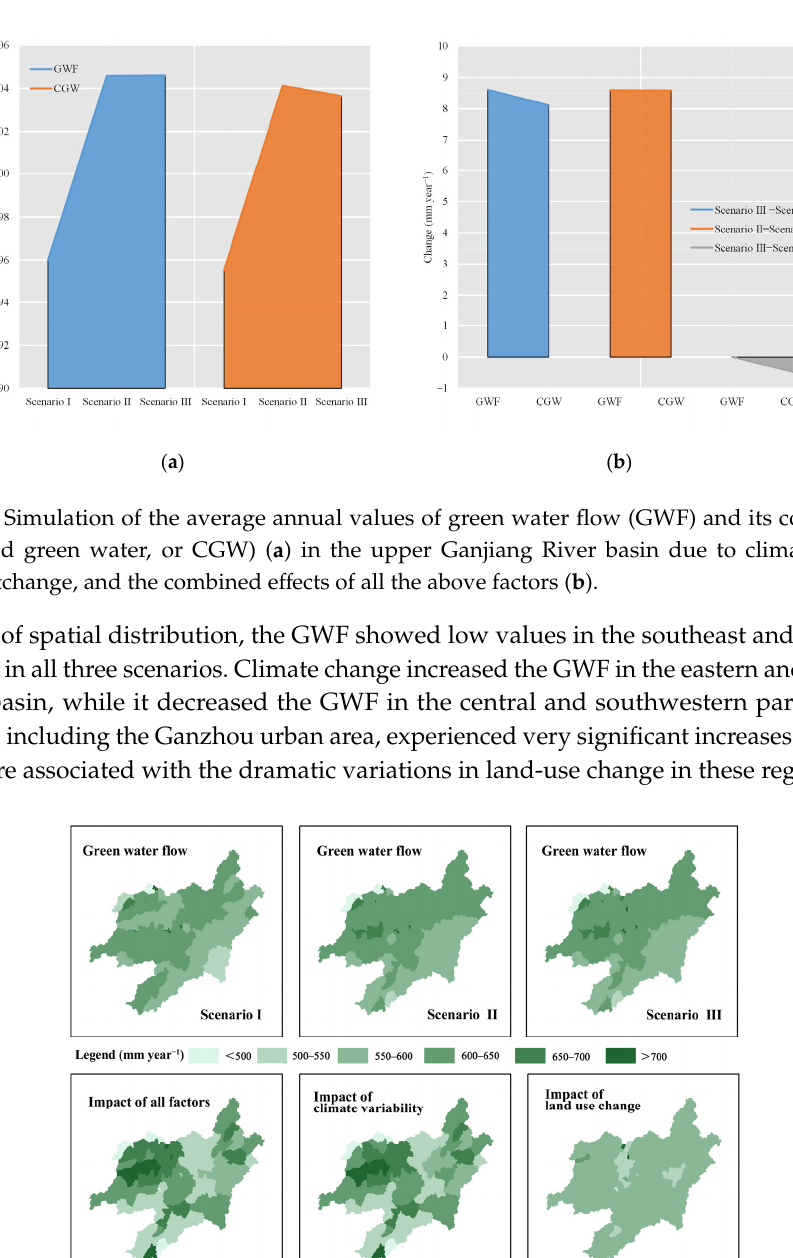
Figure 5. Spatial distribution of BWF and changes in BWF in the upper Ganjiang River basin under the individual or combined influence of climate and land-use change.